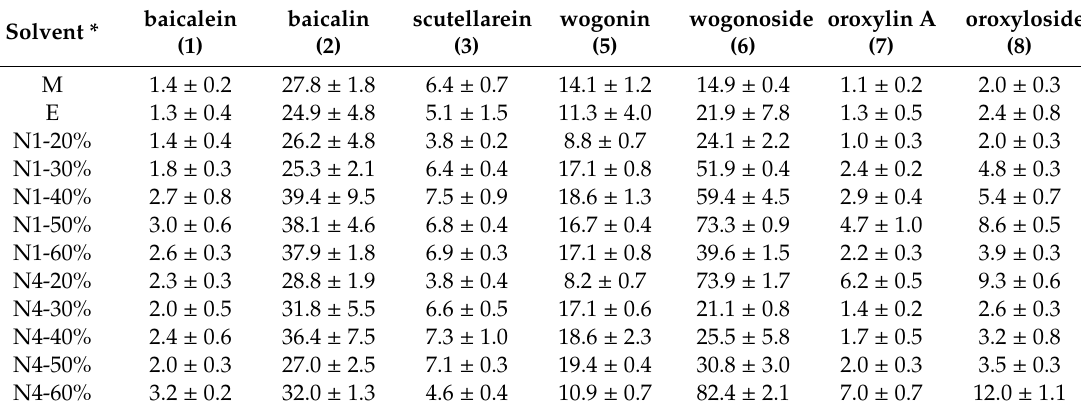
Table 1. Yield of individual flavonoids extracted from Scutellaria baicalensis root in NADES solvents N1 (citric acid— β -alanine, 1:1) and N4 (citric acid—proline. 1:1) with di ff erent water concentrations. Solvents in µ g / mg plant extract ± SD based on